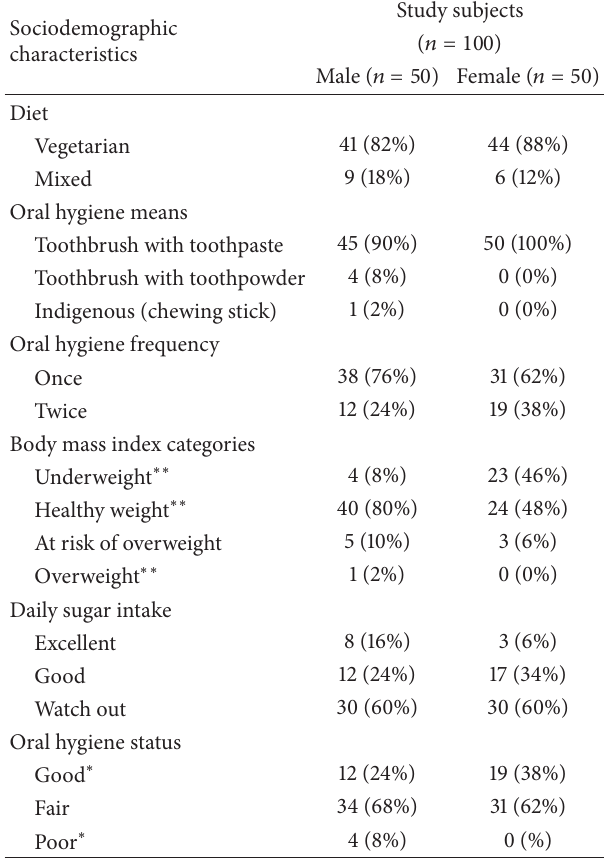
Table 2: Distribution of various characteristics of study